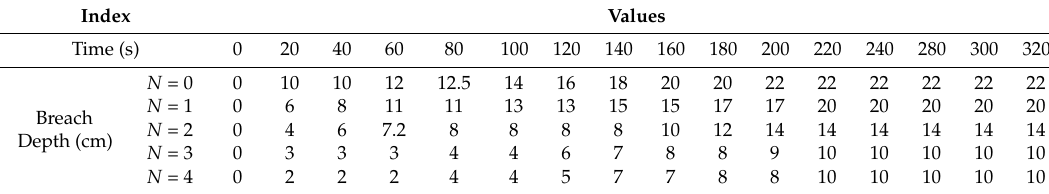
Table 3. Relationship about breach depth, reinforcement layers ( N ) and time.